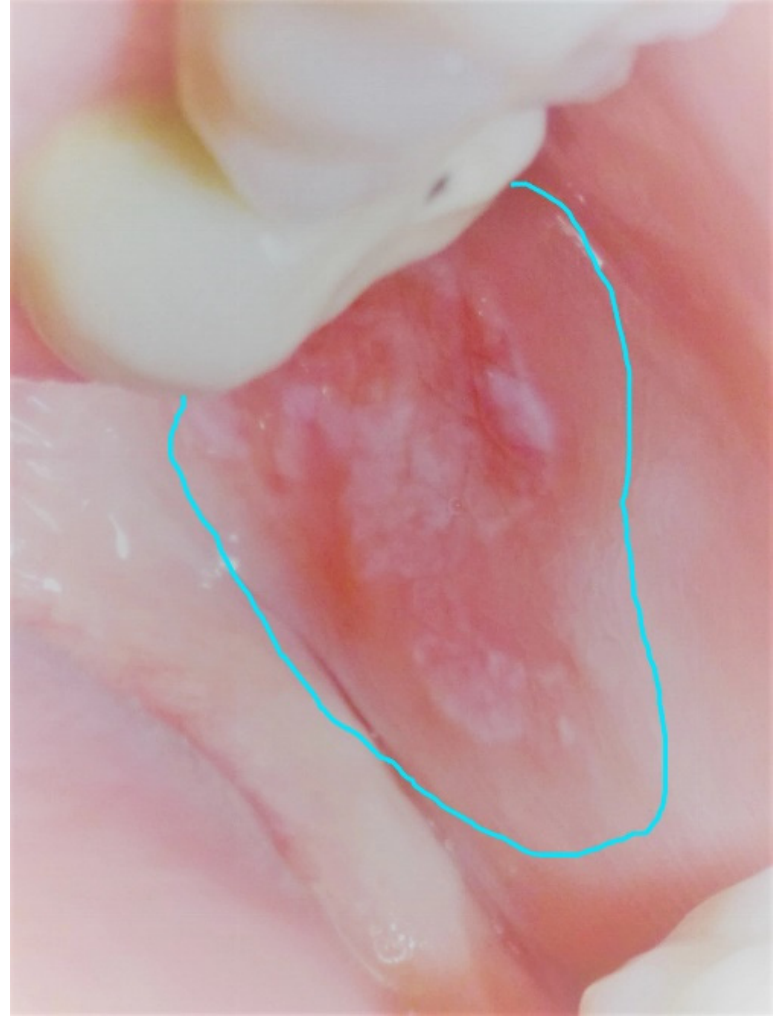
Figure 2. The limit of the area treated by PBM including the healthy area of the mucosa is drawn in a blue line. blue